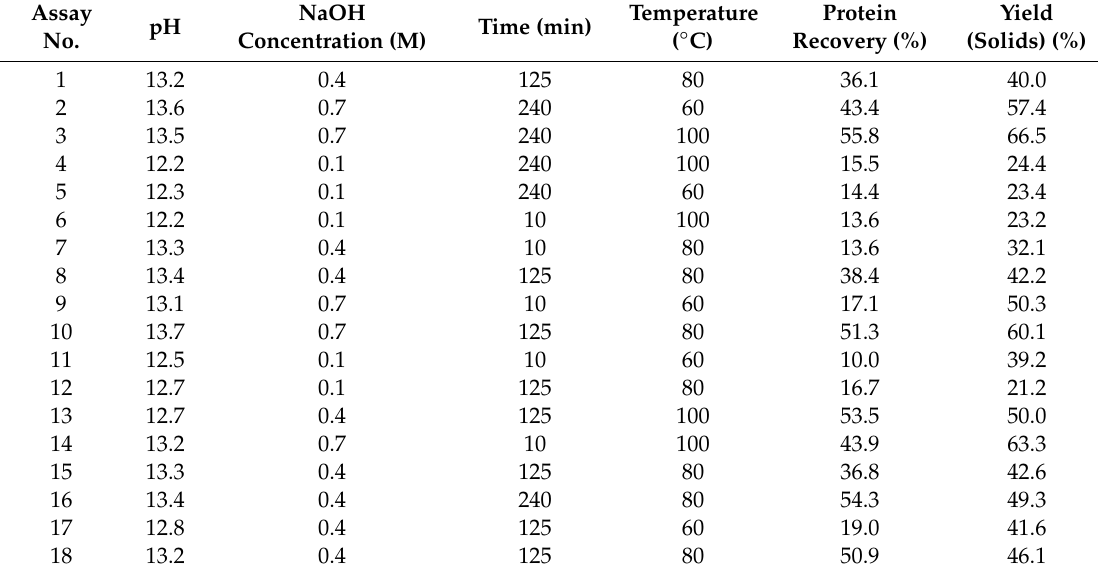
Table 4. Protein recovery from olive mill leaves subjected to di ff erent alkaline-thermal treatments (strong conditions).